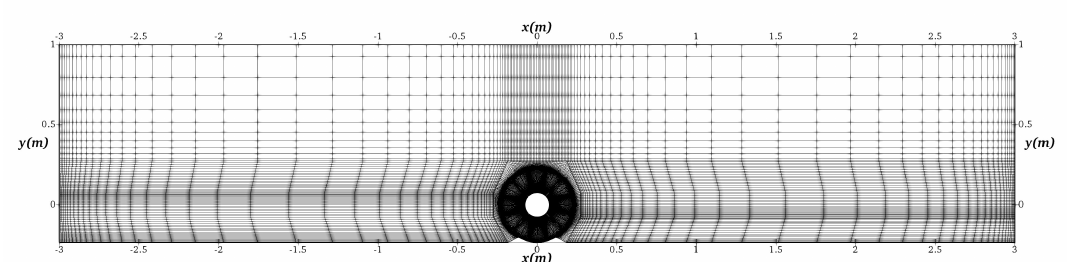
Figure 5. Computational mesh of the entire domain with dimensions in meters.